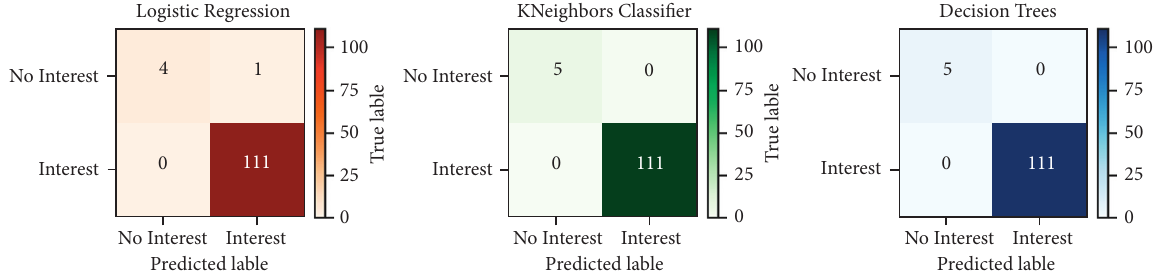
Figure 18: Comparative interpretation by different classifier